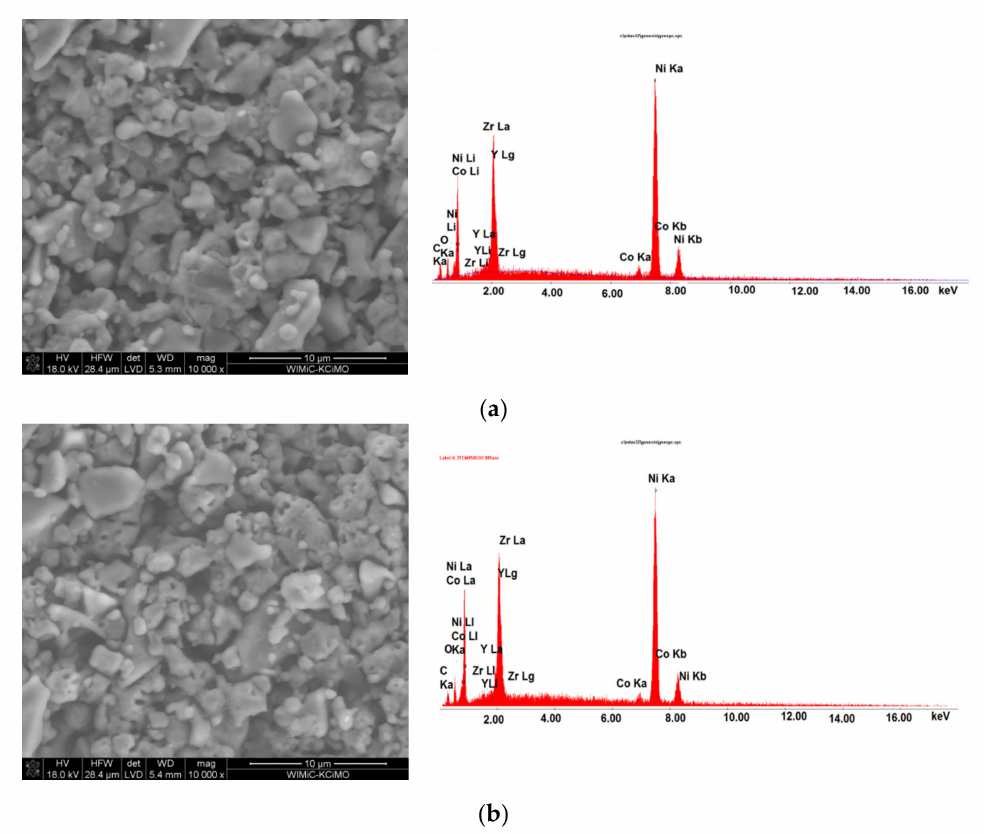
Figure 19. ( a ) SEM image recorded for Ni-GDC|Ni-YSZ anode after electrochemical test with solid fuel P300. ( b ) SEM image recorded for Ni-GDC|Ni-YSZ anode after electrochemical test with solid fuel